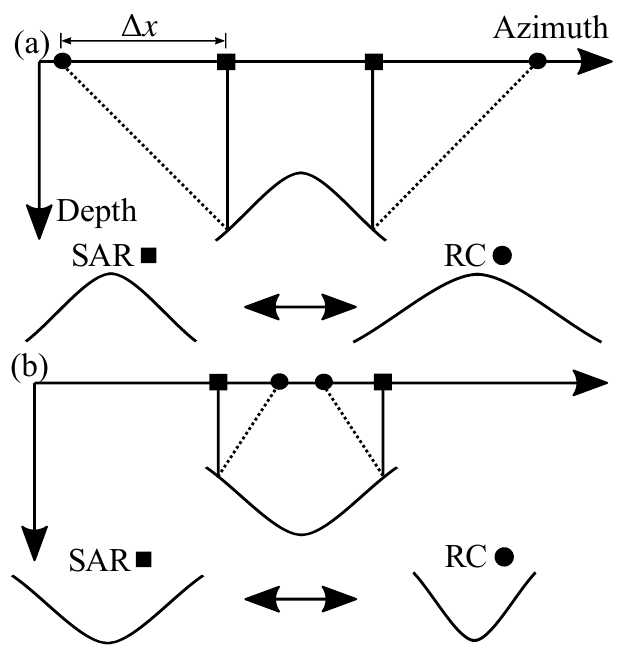
Figure 12. Azimuth displacement of a tilted internal layer in range- compressed data.